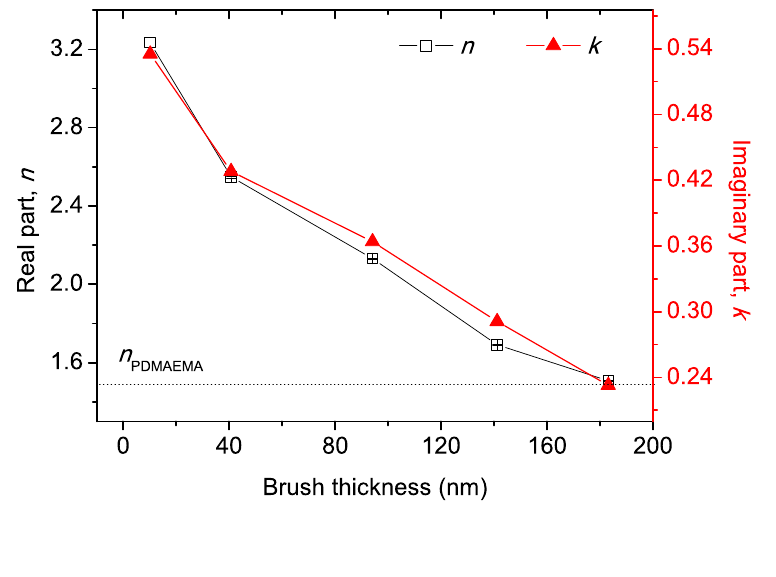
Figure 11. The real part n and imaginary part k of the complex refractive index for PDMAEMA/AuNP-13 measured by